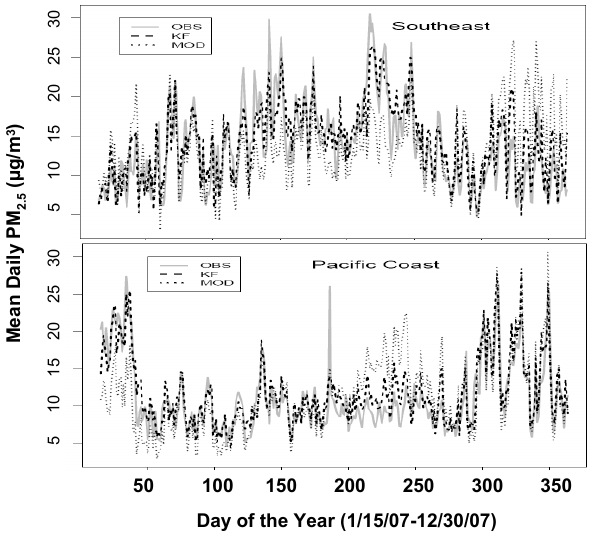
Fig. 4. Time series of observed, raw model forecast, and KF bias- adjusted forecast daily mean PM 2 . 5 (µg/m 3 ) at Southeast and Pacific Coast subregions.